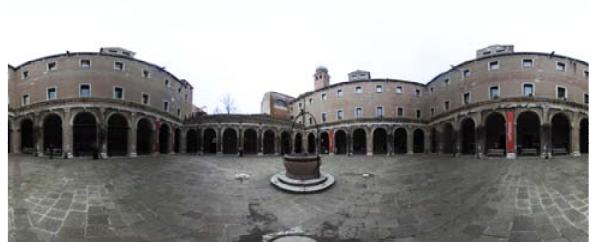
Figure 4. Spherical image acquired with the Nikon KM360.